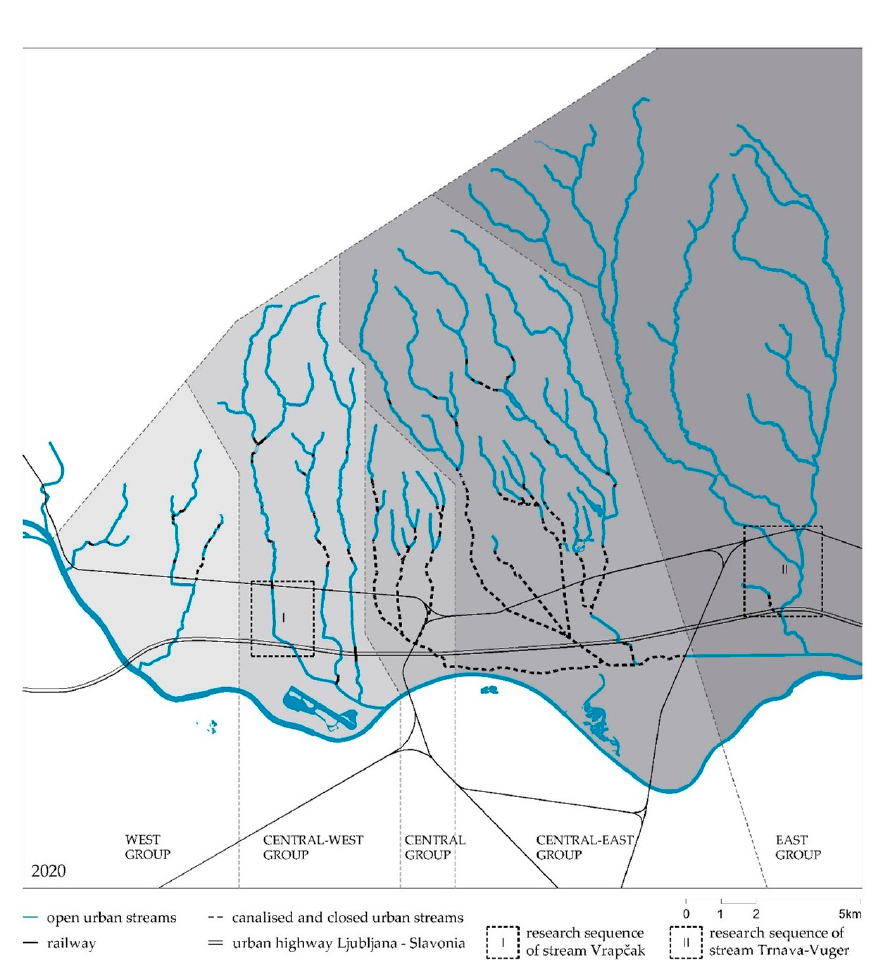
Figure 1. The current state (2020) of spatial and functional groups of Zagreb’s urban streams. Source: Authors.